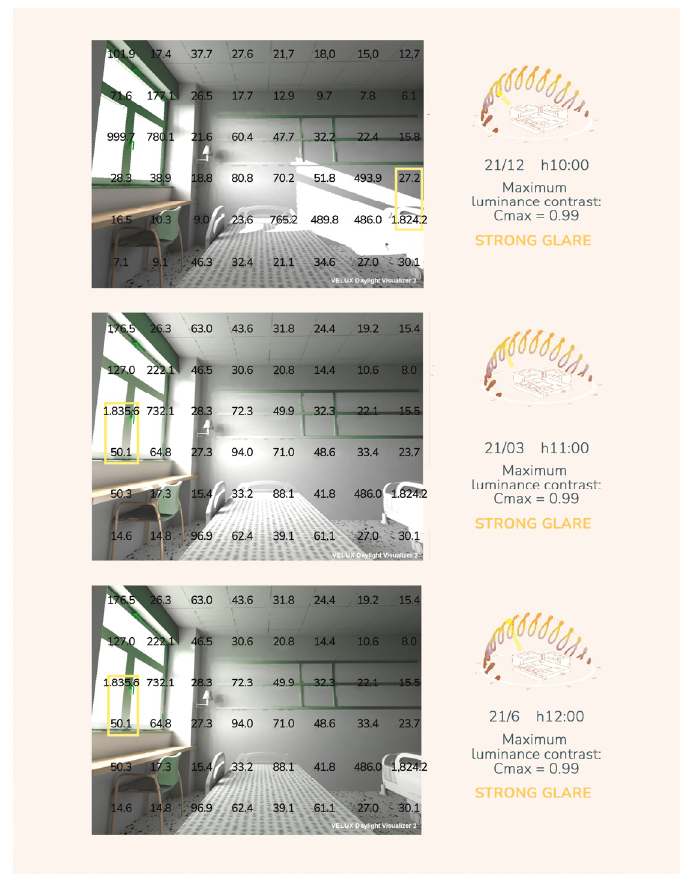
Figure 9. Luminance contrasts during the year.